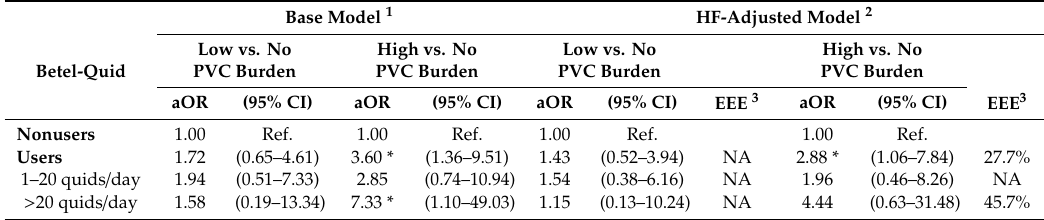
Table 5. Adjusted odds ratio (aOR) of premature ventricular contractions (PVC) burden and excessive e ff ect explained (EEE) by heart failure (HF) among Holter monitor